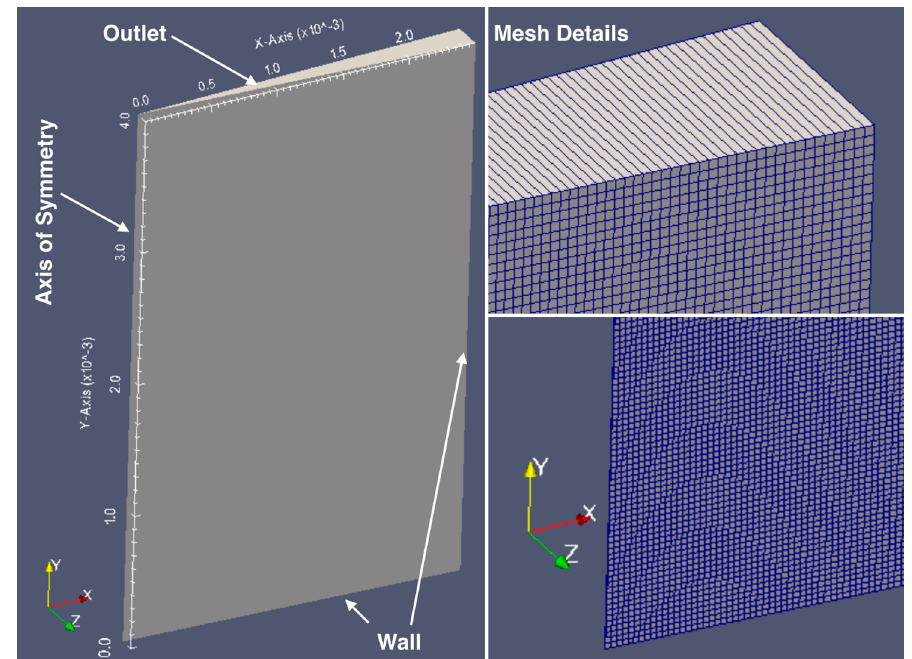
Figure 7. Computational domain, mesh and boundary conditions.